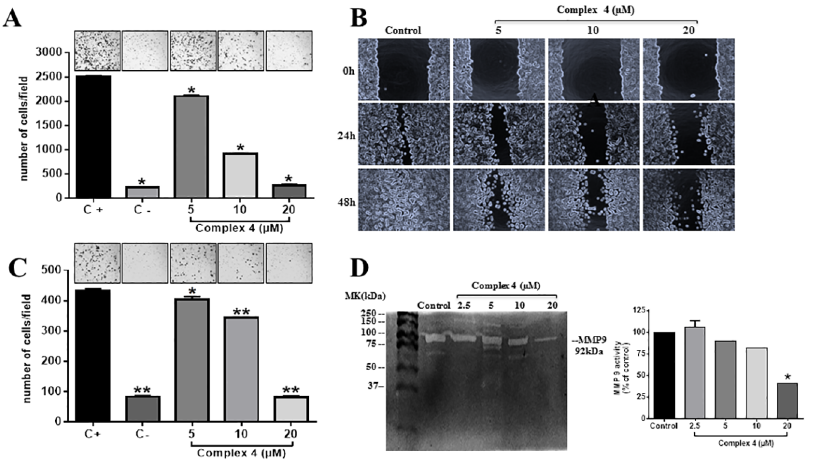
Fig 3. Effects of complex (4) on MDA-MB-231cell migration and invasion. (A) Complex was incubated with MDA-MB-231 and cells were allowedto migrate in Boydenchambers. Migratedcells were fixed and quantified by manualcounting. Representative images of the inserts are representedaboveeach condition. The wells were photographed under a light microscope under 40 × magnifications. Positive control (C+) represents migratingcells without any treatment and negativecontrol (C-) was cells migratingtoward an FBS- free medium. (B) Wound healingassay at 0, 24 and 48 h of treatment with the complex. (C) Effect of complex (4) on MDA-MB-231 cell invasionthrough matrigel. (D) Zymography in 1% gelatin-SDS-PAGE. A photograph of a representative zymography gel is shown. Gels were analyzedby densitometry, and data were normalized in percentage comparedto untreatedcontrol cell lysate. Significantat the * p < 0.005, ** p < 0.001levels using ANOVA and Bonferroni tests.